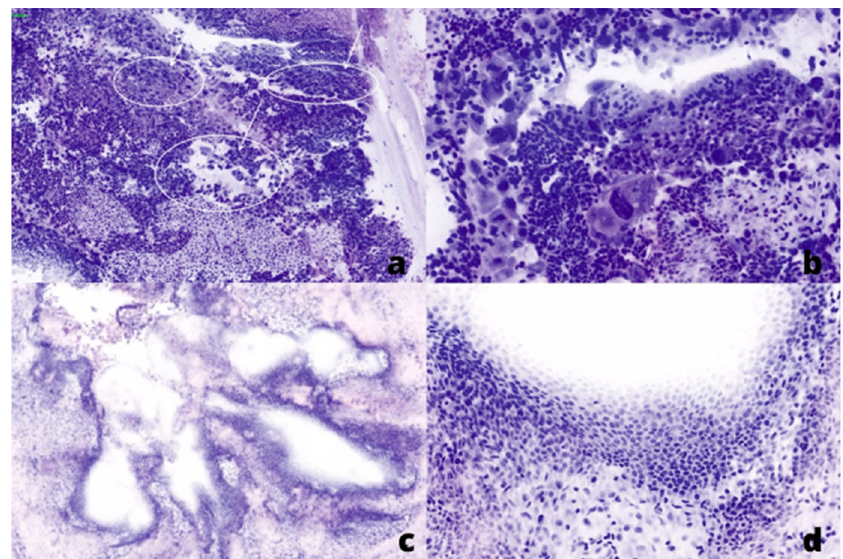
Figure 2. Fluorescent (FCM) digital microscopic images showed in Hematoxylin and Eosin (H&E) pseudo-colors: ( a , b ) from a positive ureter margin with high-grade urothelial cell carcinoma, low (×20) and high (×40) power field, respectively. ( c , d ) from a negative ureter margin, low (×5) and high (×10) power field, respectively.